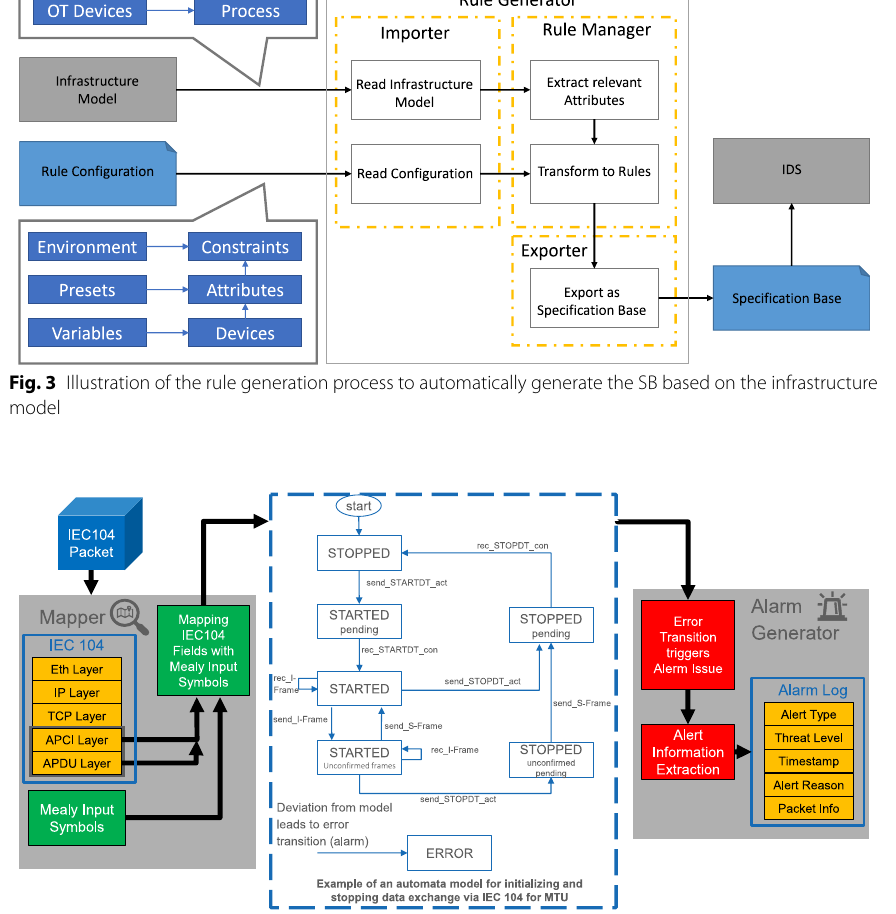
Fig. 4 Exemplary illustration of the mapper, that maps IEC-104 data packets to input symbols for the automata, which here, in an example for the MTU endpoint connection, generates according to the protocol standard a Mealy AM to stateful monitor e.g., the data